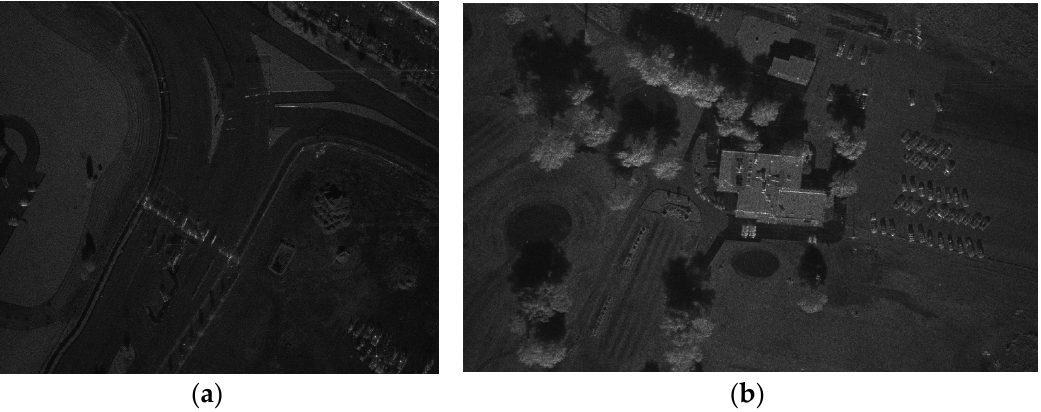
Figure 4. Two SAR images in the miniSAR dataset. ( a ) a SAR image from the training set; ( b ) a SAR image from the test set.